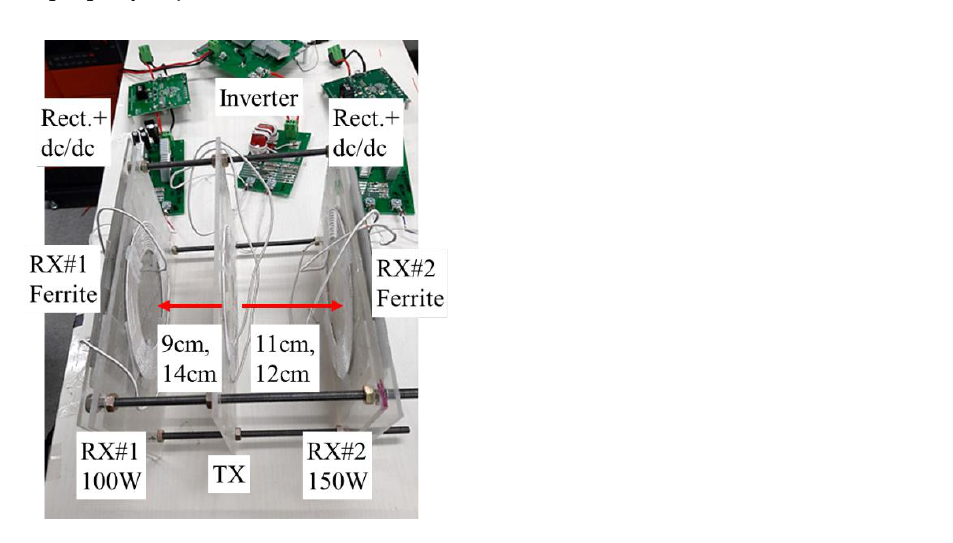
Figure 3. Experiment setup. The two RXs have different coupling from each other. The power requirement for each RX is asymmetric and is not restricted by coupling, unlike previous work. Table 1. System parameters.